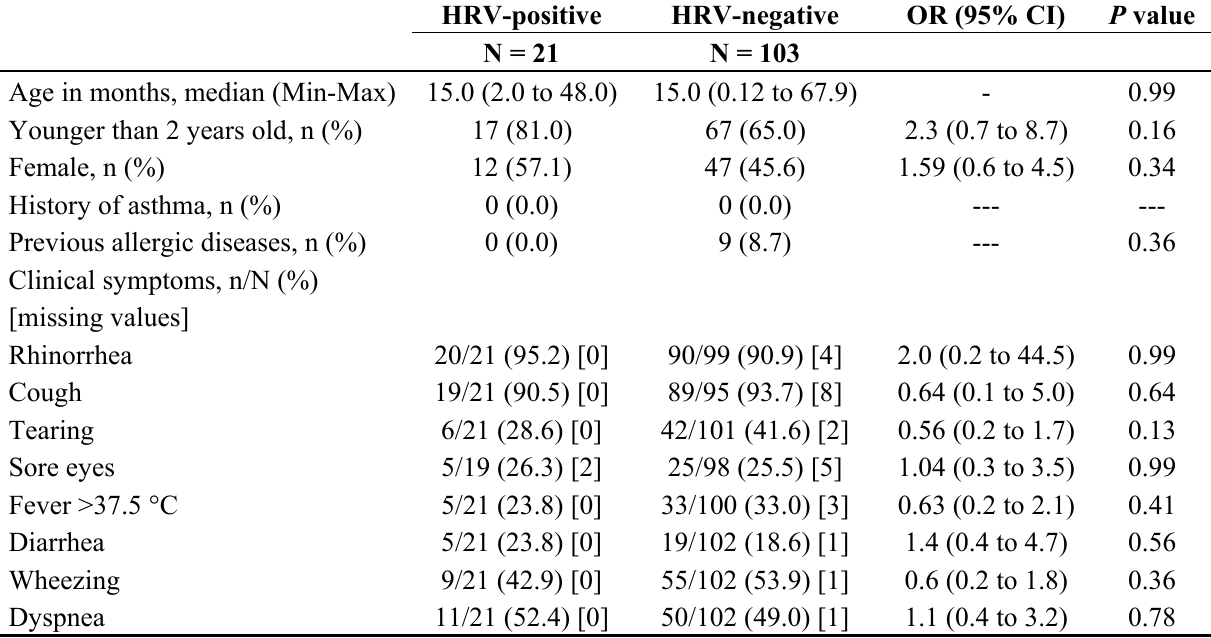
Table 1. Clinical characteristics of children with human rhinovirus infection compared with those without this